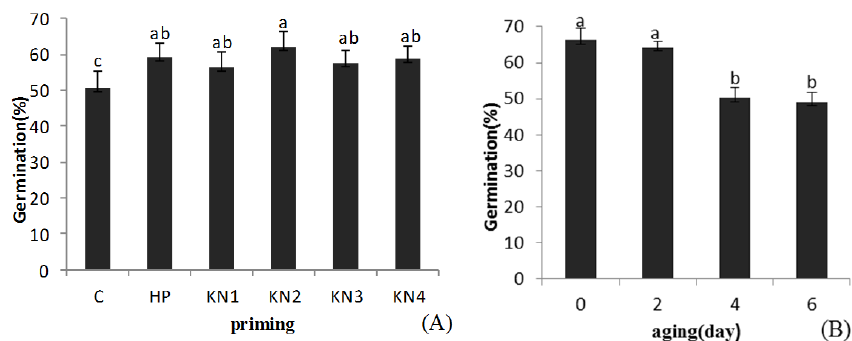
Fig. 1. Effect of seed priming and accelerated aging treatment on germination of milk thistle seeds. A (C: control, HP: Hydro Priming, KN1: Priming with KNO with KNO 3%, KN : Priming with KNO 4.5%, KN4: Priming with KNO 3 3 3 (non aging, 2 day aging, 4 day aging and 6 day